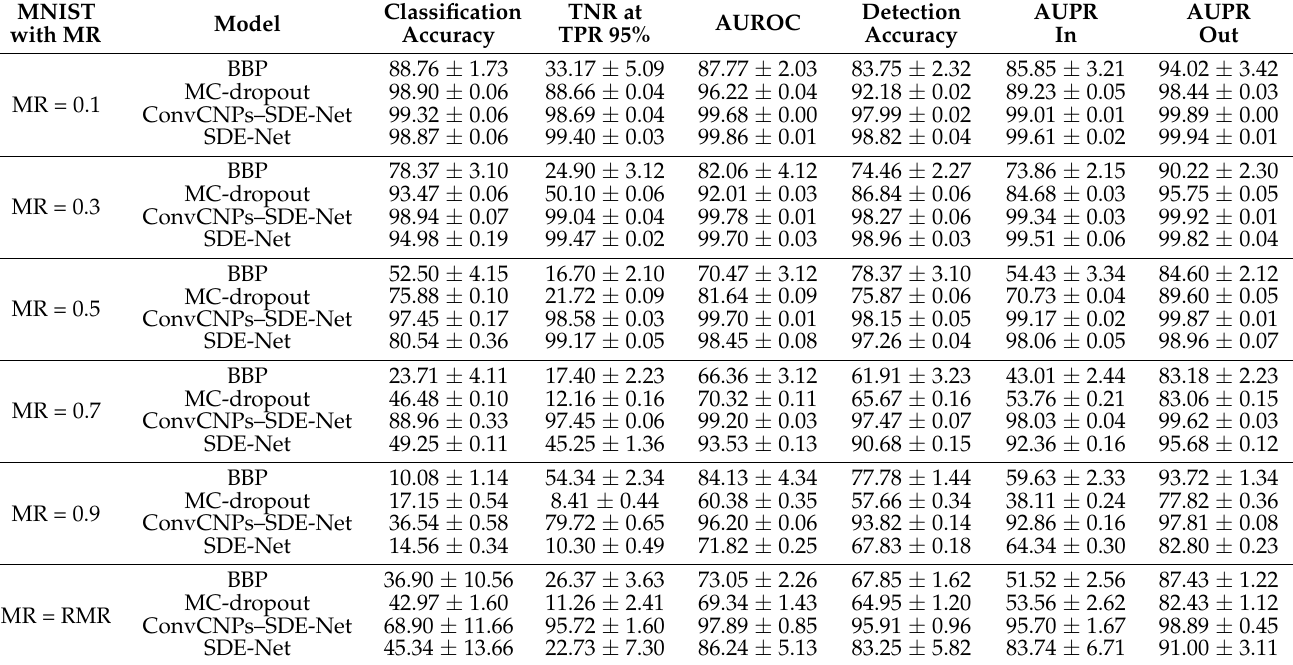
Table 3. OOD detection results of the BBP, MC-dropout, ConvCNPs–SDE, and SDE-Net models on ID dataset MNIST with